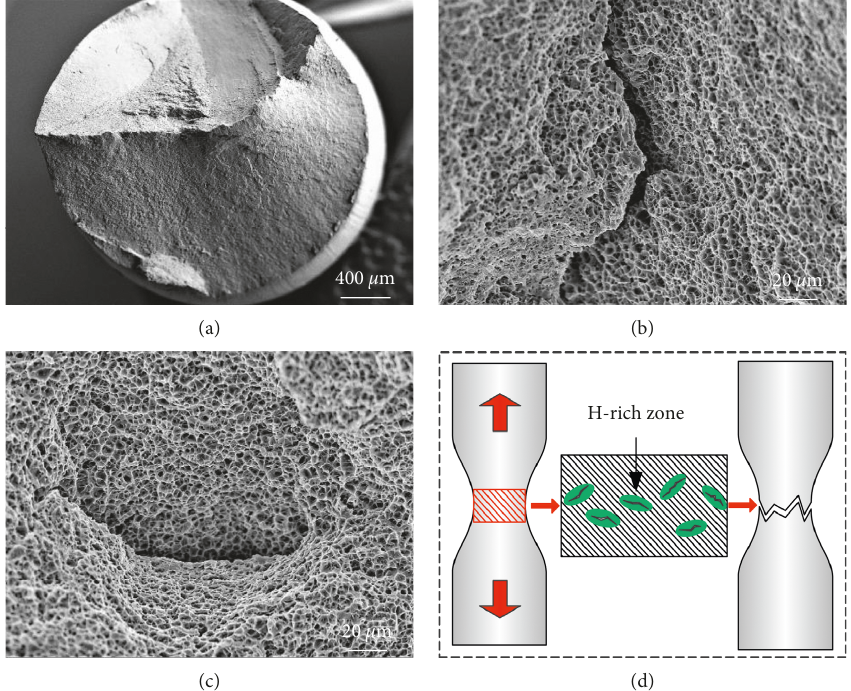
Figure 7: The fracture morphology of the ϕ 5.2 mm wire with hydrogen content of 0.26 μ g/g. (a) Macroscopic morphology of the fracture; (b) and (c) microscopic view of the internal cracks; (d) schematic diagram of the H-rich zone and internal